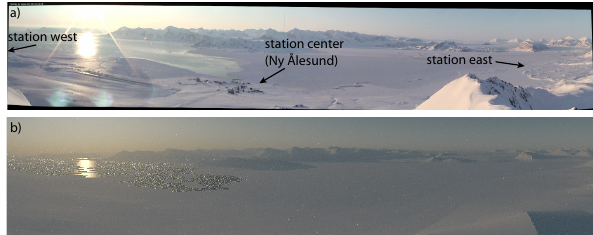
Figure 2. (a) Webcam view towards the north from Zeppelin moun- tain overlooking Ny Ålesund on 8 May 2009, 22:00UTC. The lo- cations of two stations are visible, station west is further to the west. Due to low wind speed, a pronounced sun glint is visible over the ocean. (b) With MYSTIC, the simulated radiances (RGB) with a BRDF model for water reflection (Cox and Munk, 1954, with 2ms − 1 wind speed) show the same effect and indicate a realisti- cally modeled